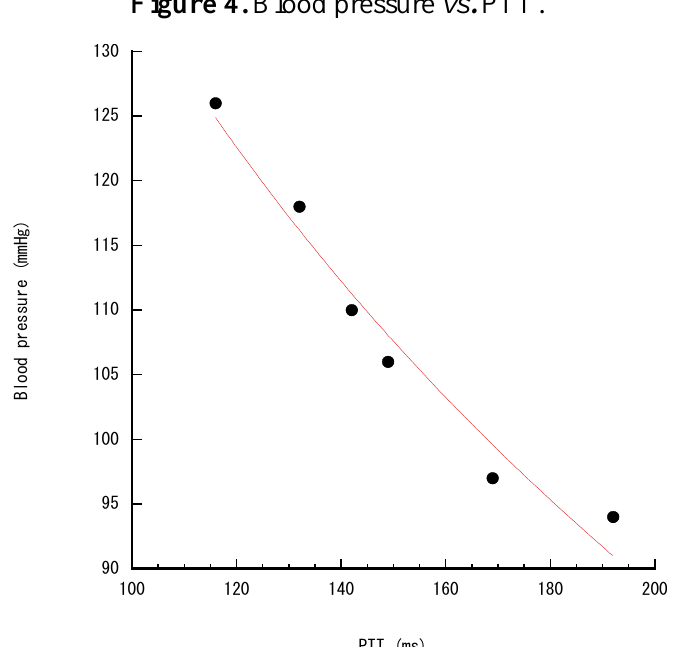
Figure 4. Blood pressure vs.